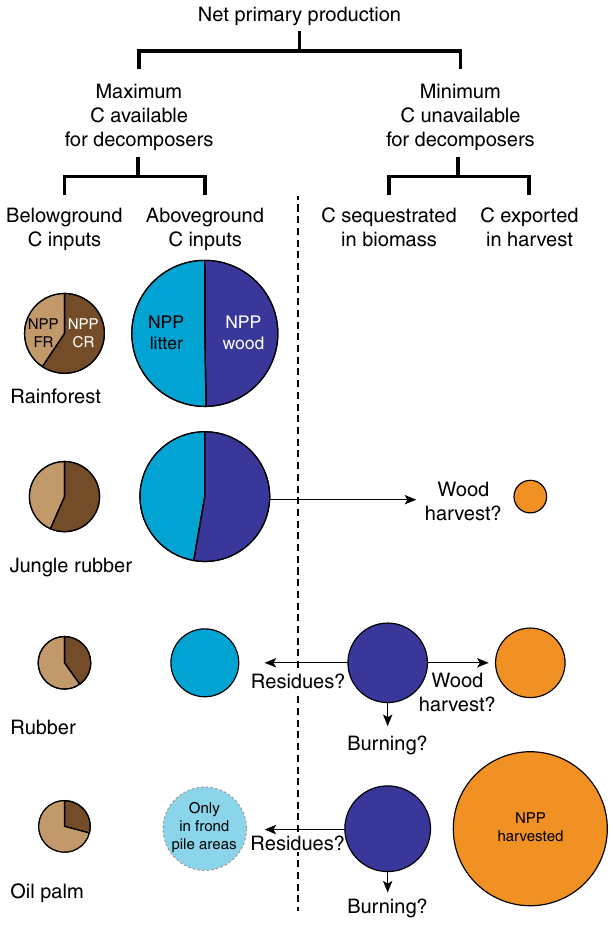
Fig. 3 Share of net primary production between biomass pools available or unavailable for decomposer food webs in the land-use types. Biomass production of fi ne roots (NPP FR), coarse roots (NPP CR), litter (NPP litter) and wood (NPP wood) will be eventually fully decomposed in the ecosystem in opposite to the harvested (NPP harvested) and wood (NPP wood) biomass in monocultures. Arrows represent various fate of wood